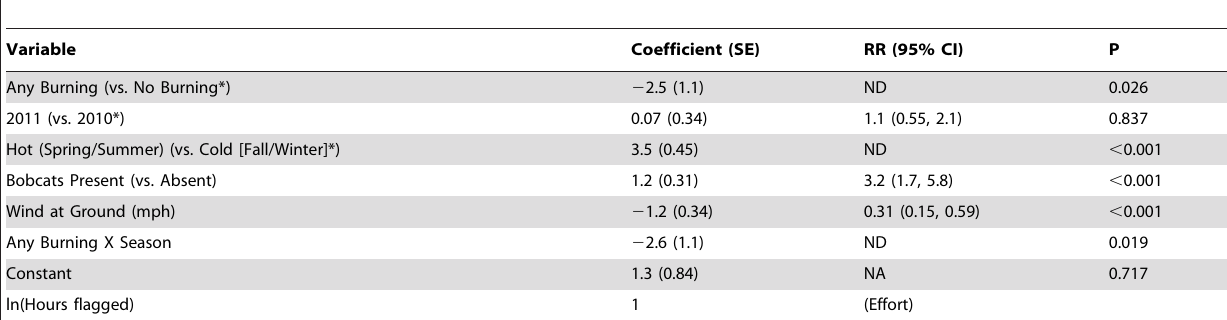
Table 4. Generalized estimating equation negative binomial regression model for the prediction of A. americanum counts at all study 21